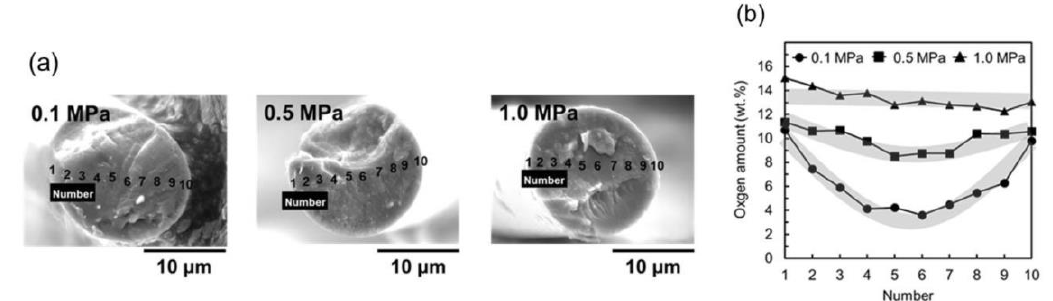
Figure 6. Distributions of the amounts of oxygen uptakes in the transversal sections of ARMP stabilized fiber (ARMP-SF)14s using SEM-EPMA: ( a ) measuring points of the amounts of oxygen uptakes in ARMP-SF14s and ( b ) distributions of the amounts of oxygen uptakes in the transversal sections of ARMP-SF14s.